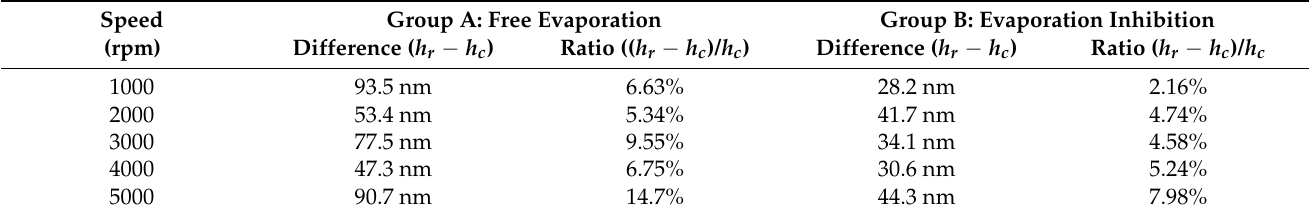
Table 2. Film thickness under different conditions.